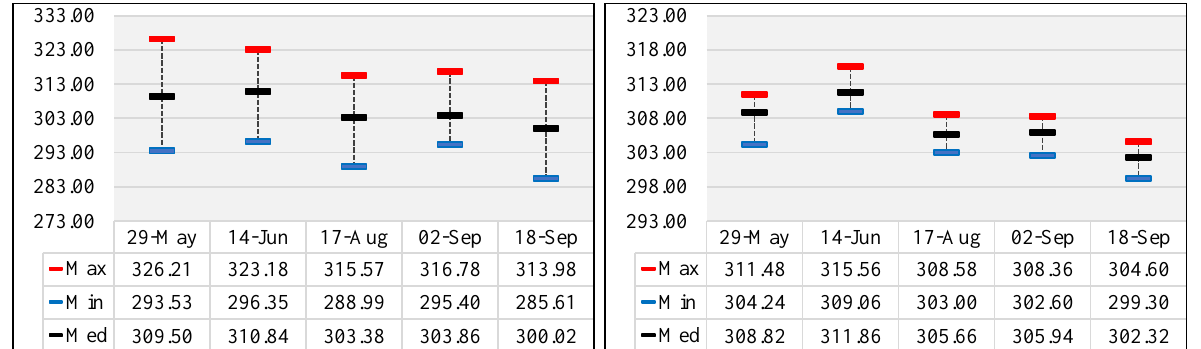
Figure 2. Maximum, minimum and median temperatures for Landsat 8 (left) and MODIS (right) LST in Kelvin